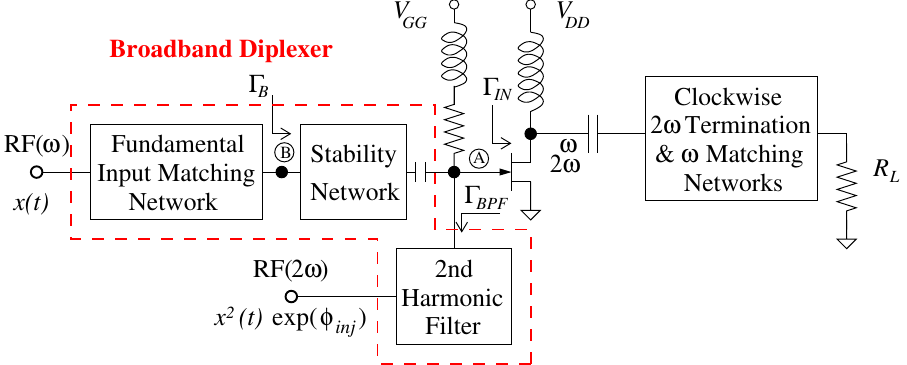
Figure 1. Circuit blocks for the clockwise loaded class-J PA wih input second-harmonic injection using a broadband